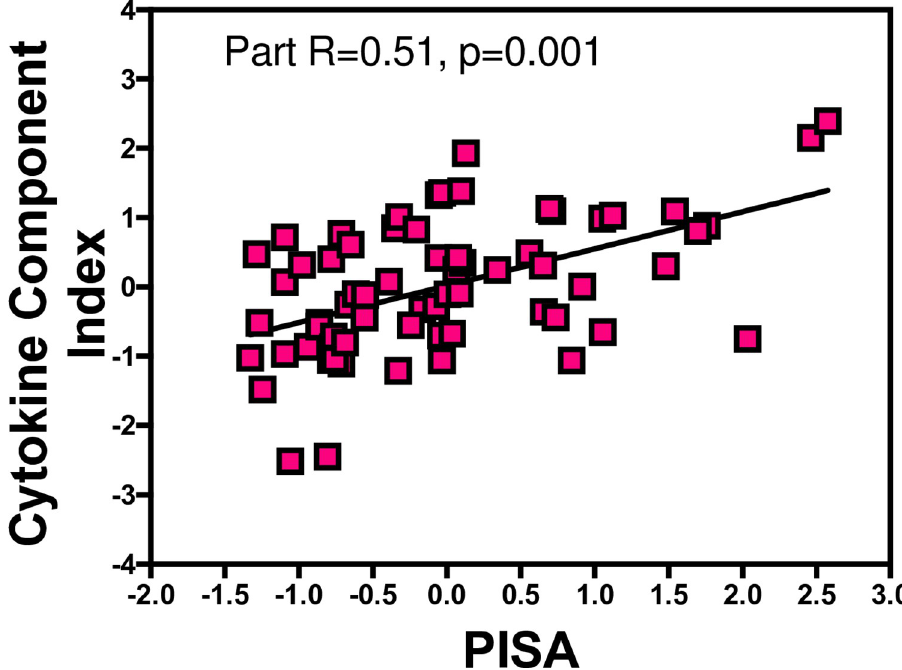
Fig 1. Partial regression plot showing the relationships between PISA and salivary CCI. The x and y axes are the residuals for PISA and CCI adjusted for age, gender and BMI. The partial R and p values are shown.